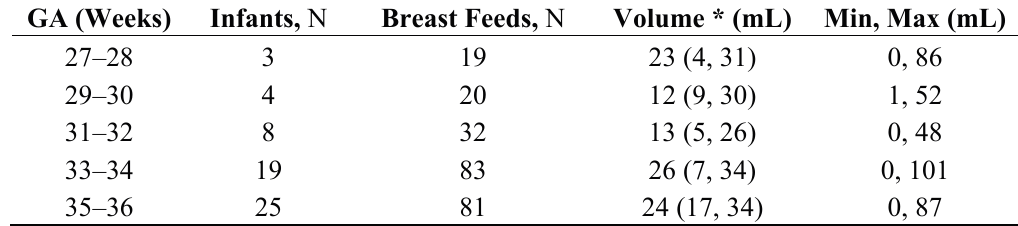
Figure 3. Bland-Altman plot of the agreement between the prescribed feed volume in mL/day and the actual intake of the infant for infants receiving >2 breastfeeds in 24 h. Each point represents one infant’s intake over 24 h for infants receiving >2 breastfeeds (N = 20). Table 2. Median breast milk intake (mLs) per breastfeed according to gestational age (GA) at birth. GA